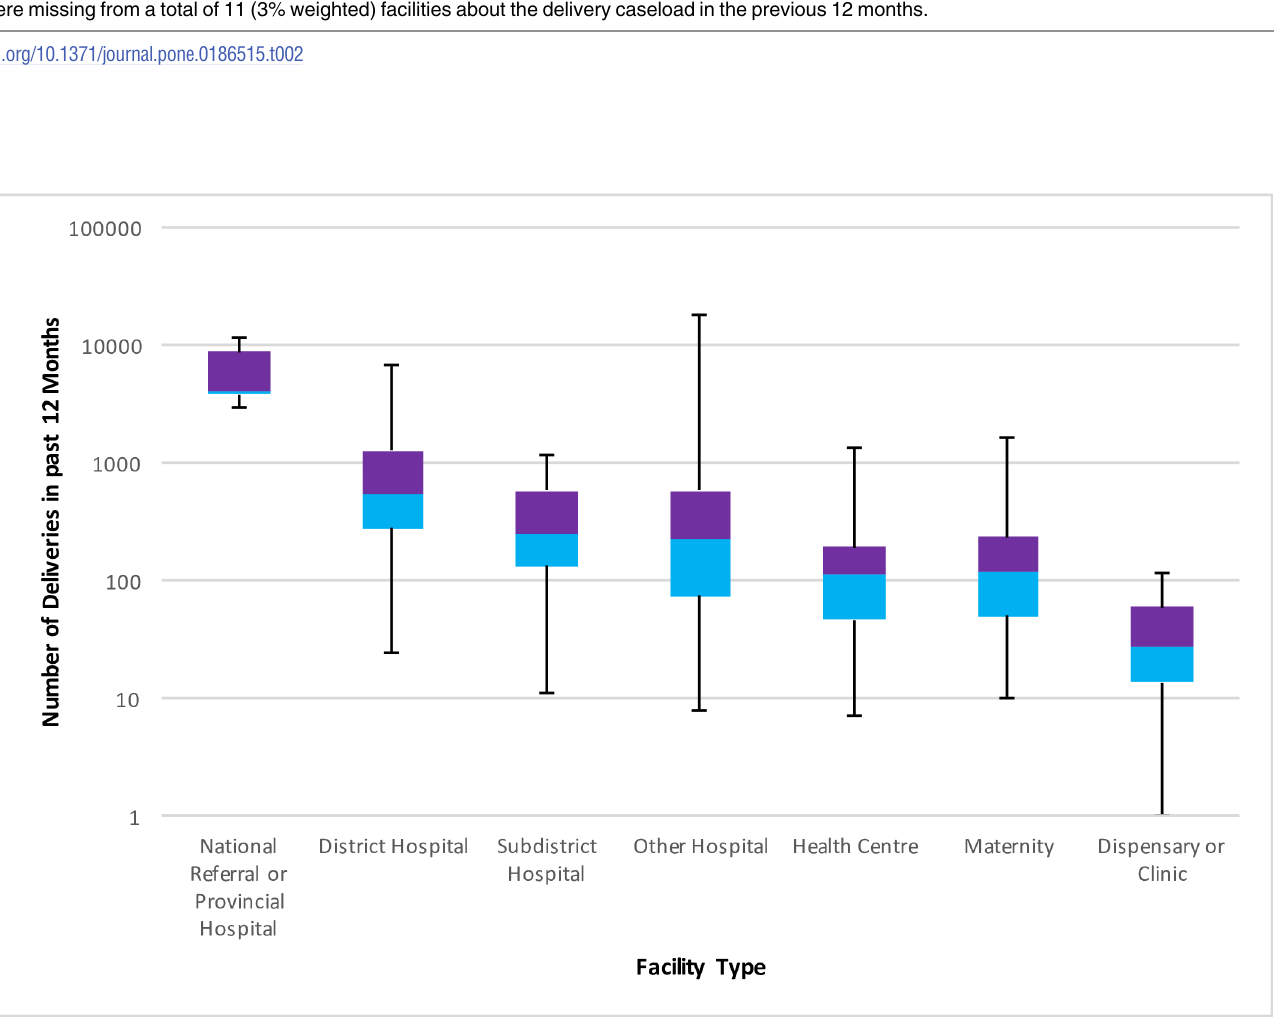
Fig 3. Boxplot showing distribution of number of deliveries across facility type. Median,interquartile range, minimum and maximum numberof deliveriesin each facility type are